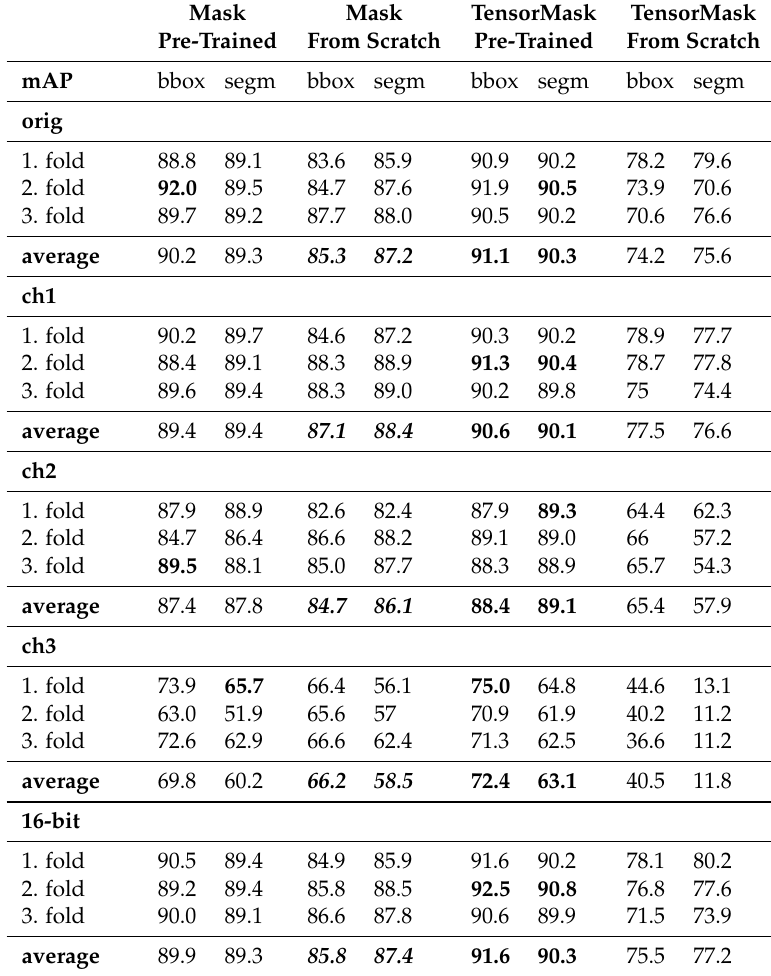
mAP. The folds of model training for three different training and testing datasets were repeated twice. Presented result values are the best selected repetition. Table 7. 3-fold cross-validation mean Average Precision (mAP) results for pre-trained (four batch, 2000 epochs) and trained from scratch (two batch, 100,000 epochs) models of Mask R-CNN and